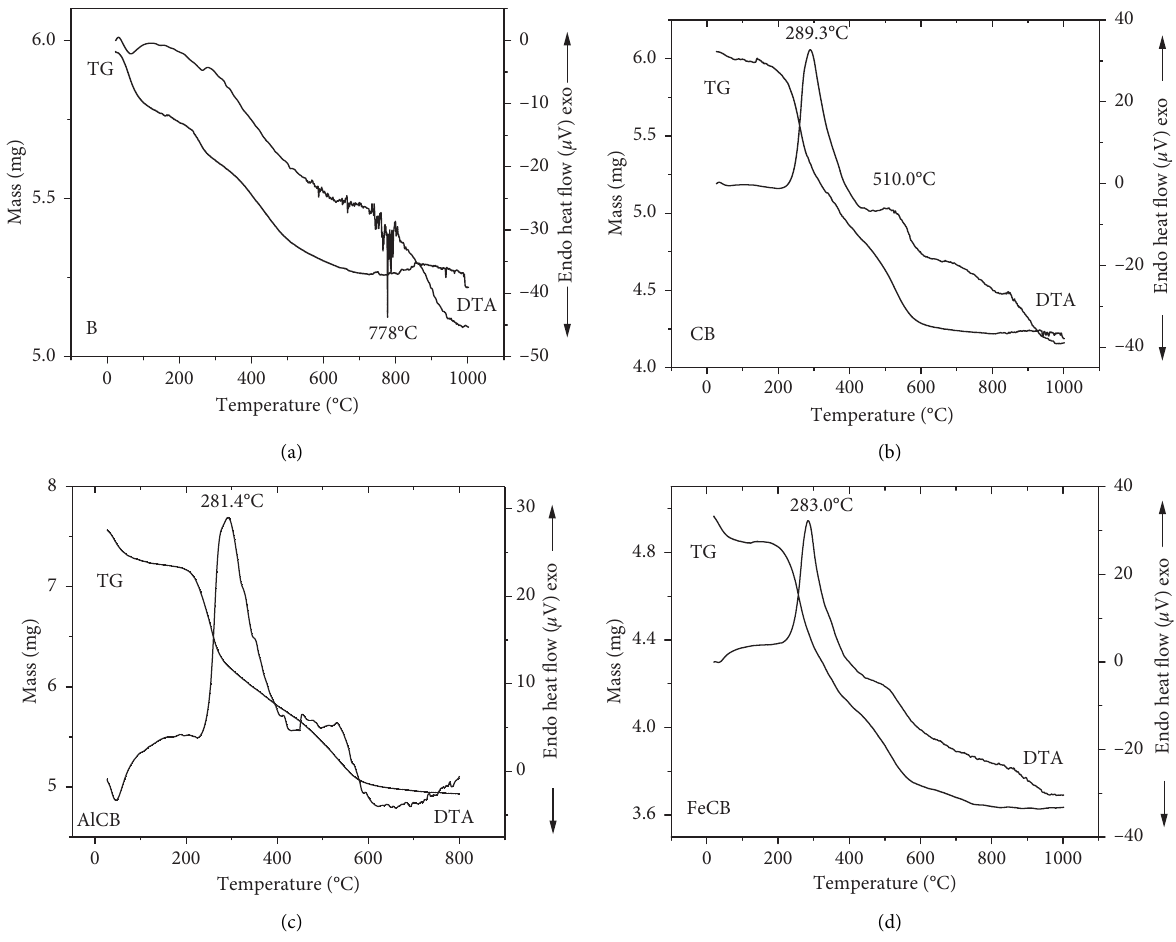
Figure 4: TG and DTA curves of (a) B, (b) CB, (c) AlCB, and (d)